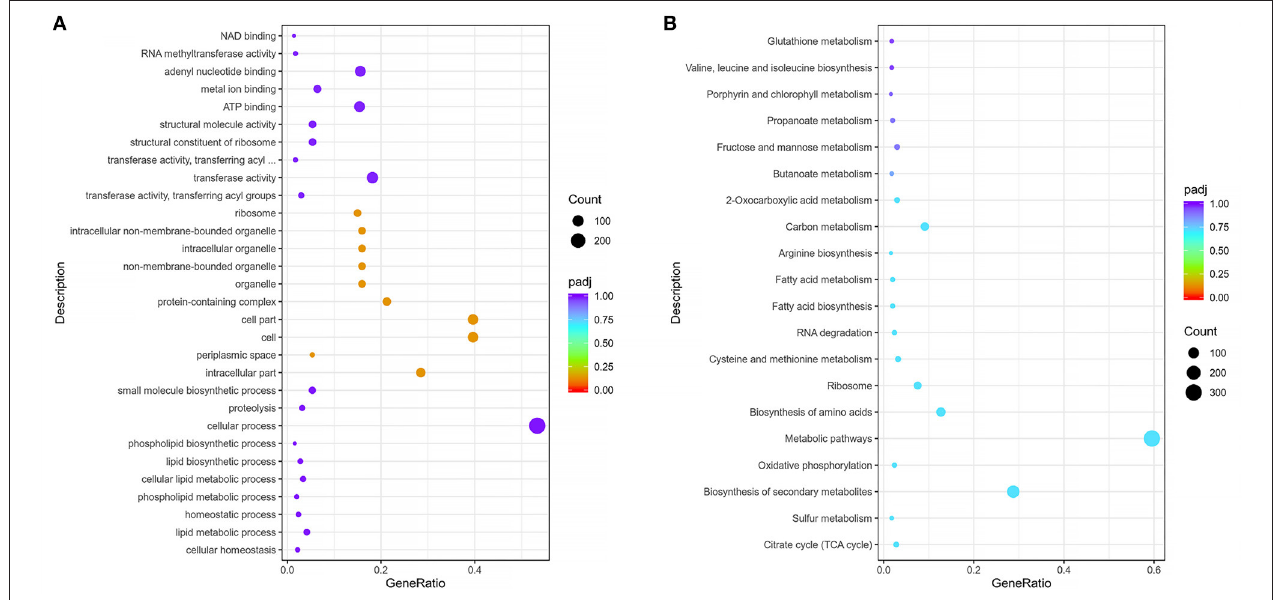
FIGURE 7 | Scatter plot of GO and KEGG enrichmen. (A) Top 30 enriched GO function and DEGs numbers enriched in each function of Pm3/Pm64. (B) Top 20 enriched KEGG pathways and the number of DEGs in of Pm3/Pm64. The abscissa represents the ratio of DEGs annotated to the total differential genes; the ordinate represents the GO Term and KEGG pathway, respectively; the size of the point represents the number of annotated genes; the color from red to purple represents the decreasing significance of enrichment.